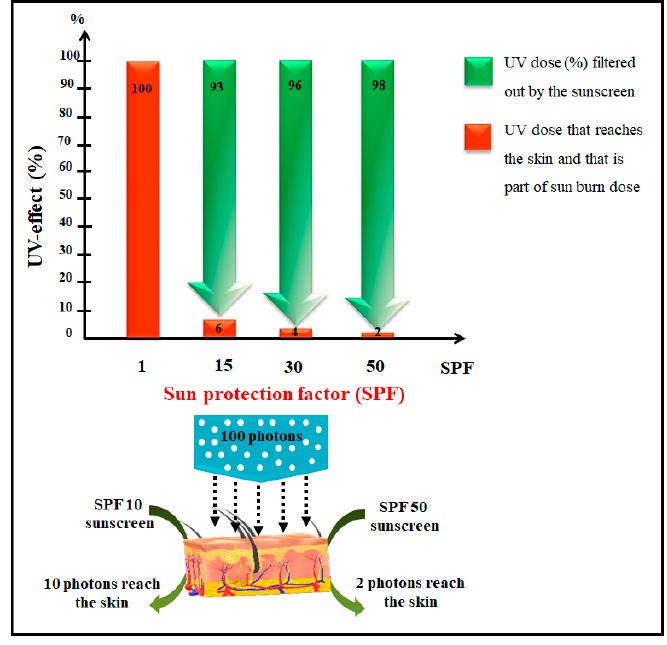
Figure 2. Illustration of the sun protection factor (SPF) definitions, including filtered and transmitted UV radiation [18].